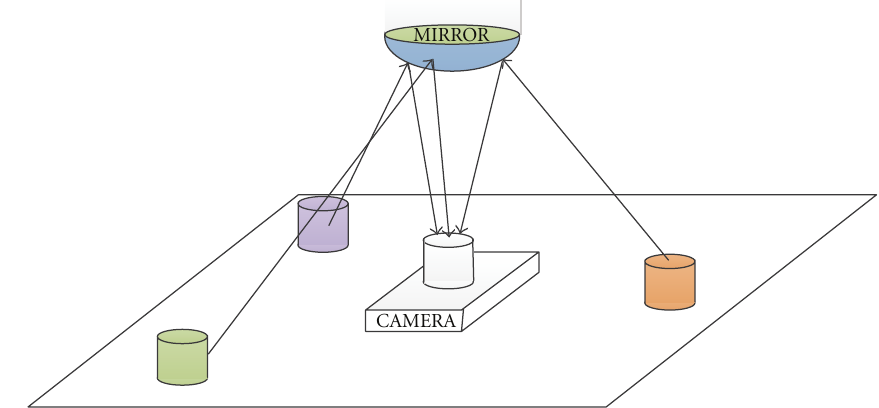
Figure 1: Catadioptric system.